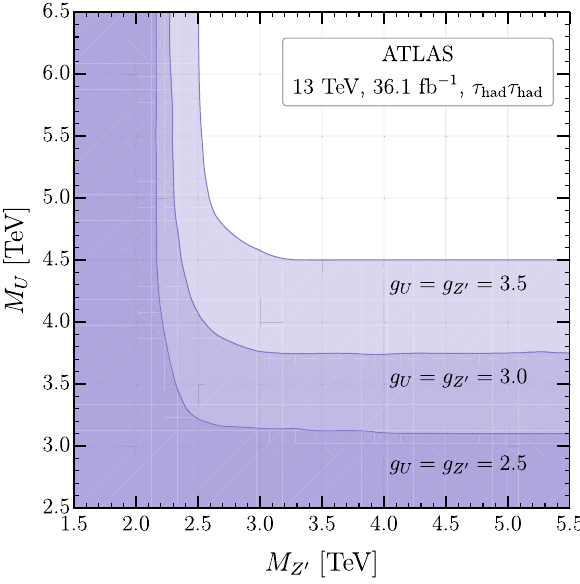
Fig. 3 Exclusion plot for the pp → ττ search in the ((cid:16) Z (cid:2) / M Z (cid:2) , M Z (cid:2) ) plane for ζ ll q = { 0 . 0 , 0 . 5 , 1 . 0 } for dotted, dashed and full lines, respec- tively. The grey area shows values of the width which are below the corresponding natural width